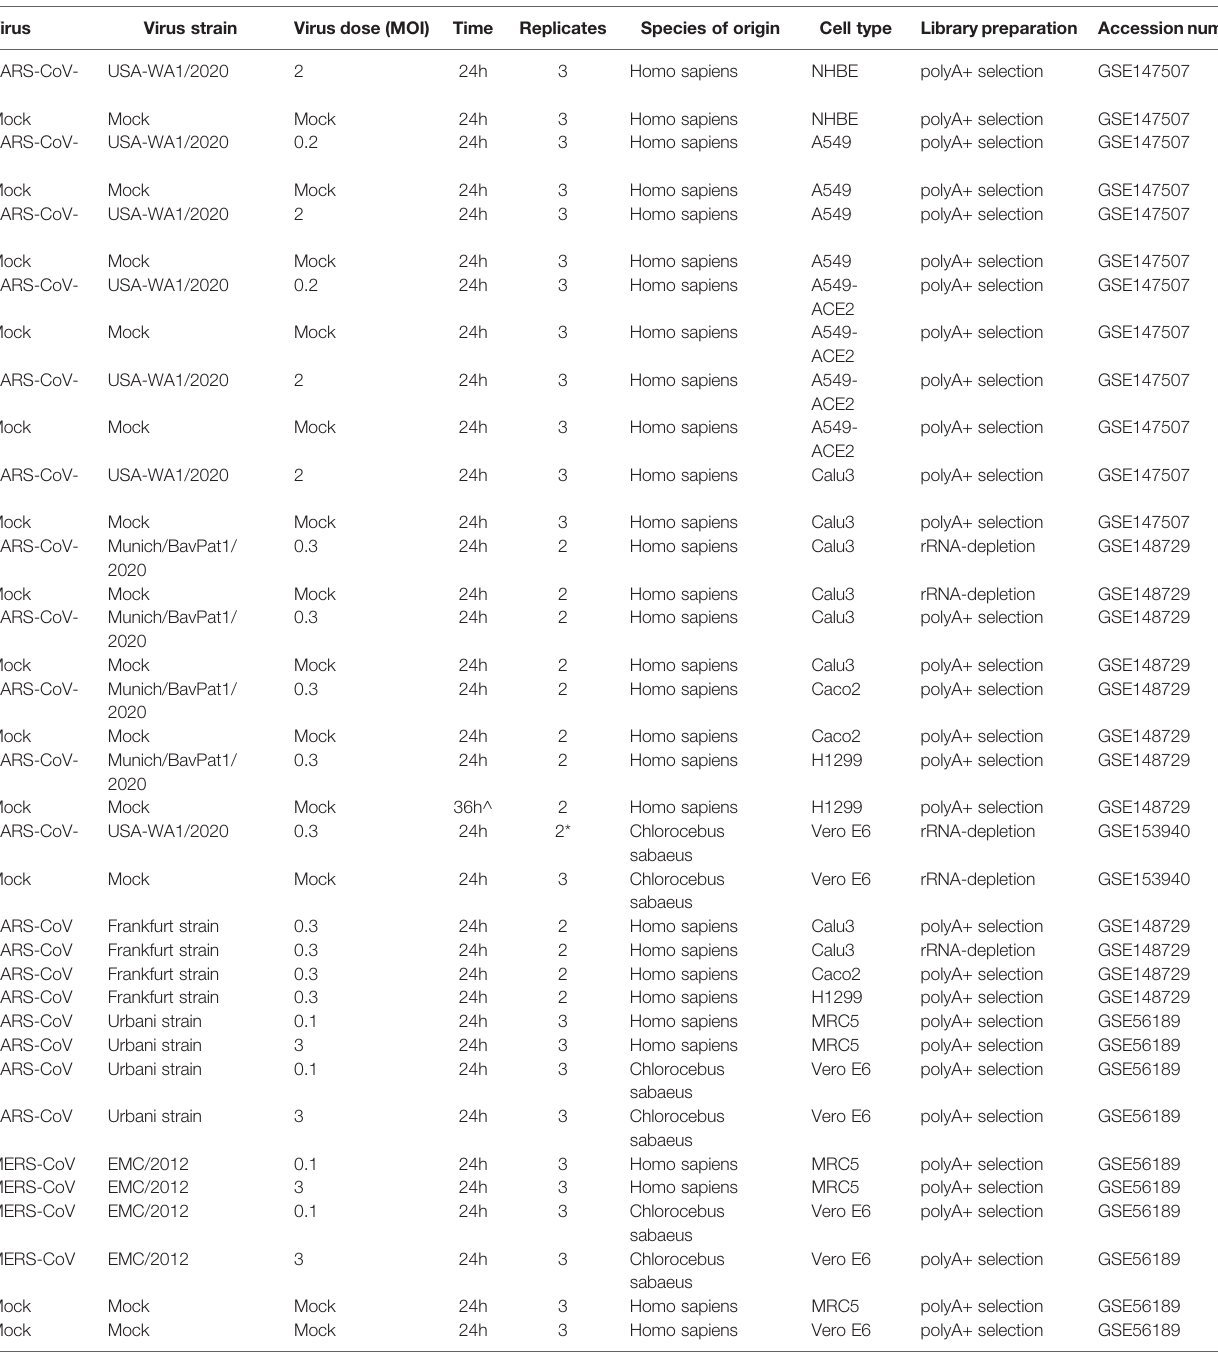
TABLE 1 | Data of cell lines (cells) included in this